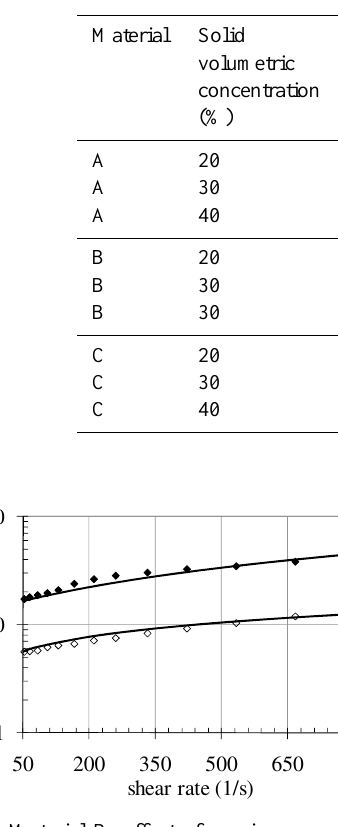
Table 3. Bingham generalized model parameters.